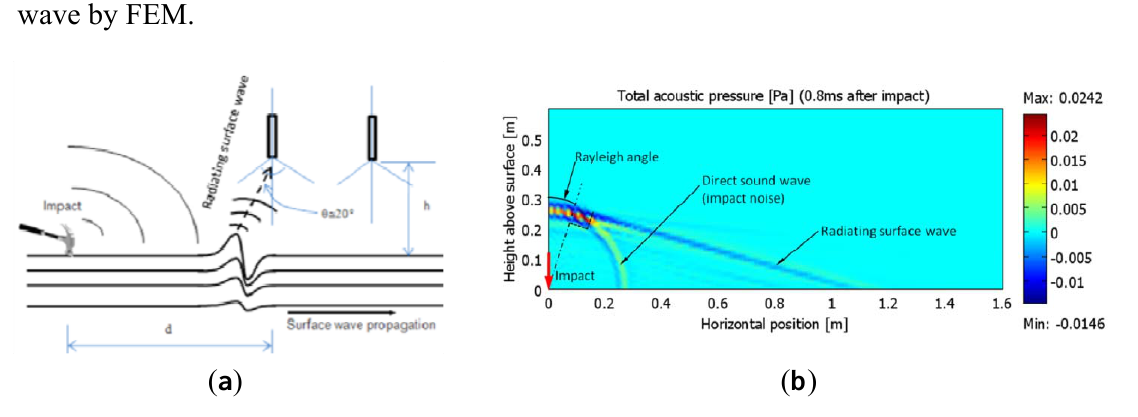
Figure 2. ( a ) Propagation of radiating surface wave. ( b ) Visualization of radiating surface wave by